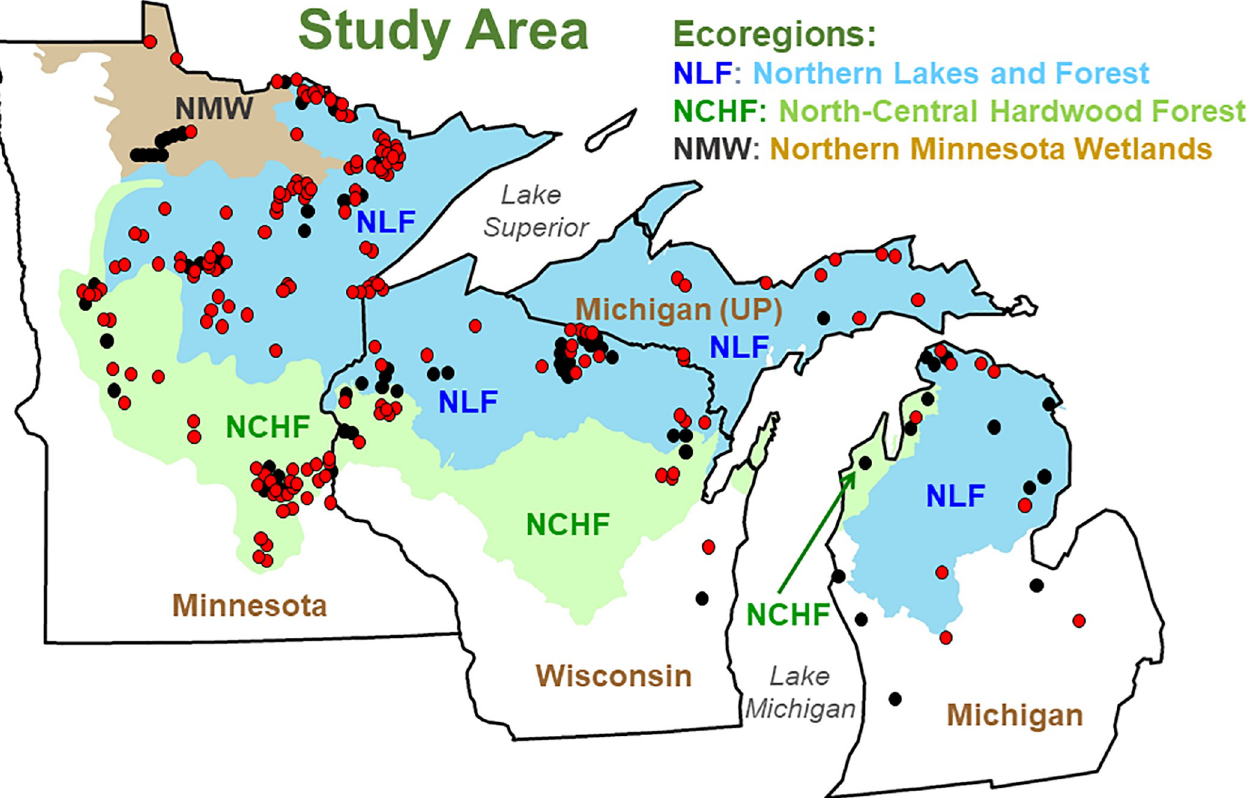
Fig 1. Map of study area showing ecoregions and sampling sites. Red circles: sites with Fe diss , a 440 and DOC data; black circles: additional sites with only a 440 and DOC data.